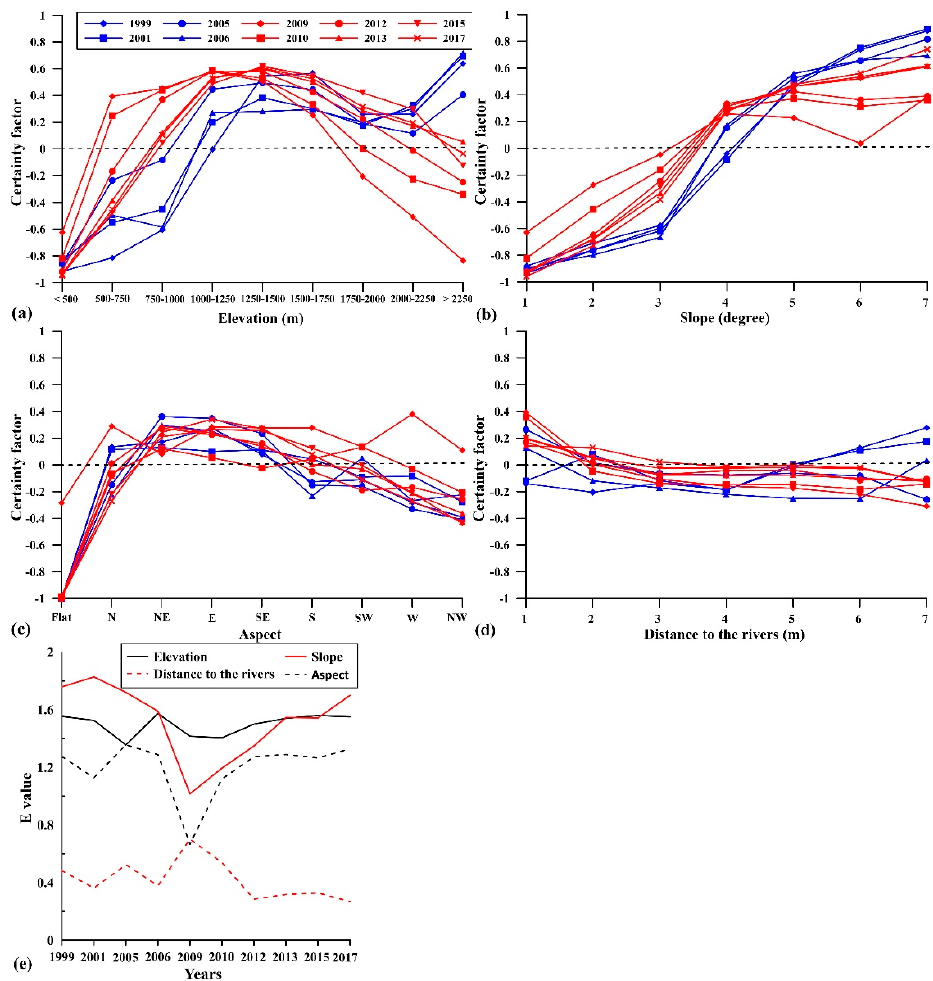
Figure 6. The certainty factor analysis in regard to elevation ( a ), slope ( b ), aspect ( c ), and distance to the rivers ( d ) and the E index values for these four factors ( e ) in the Chishan river